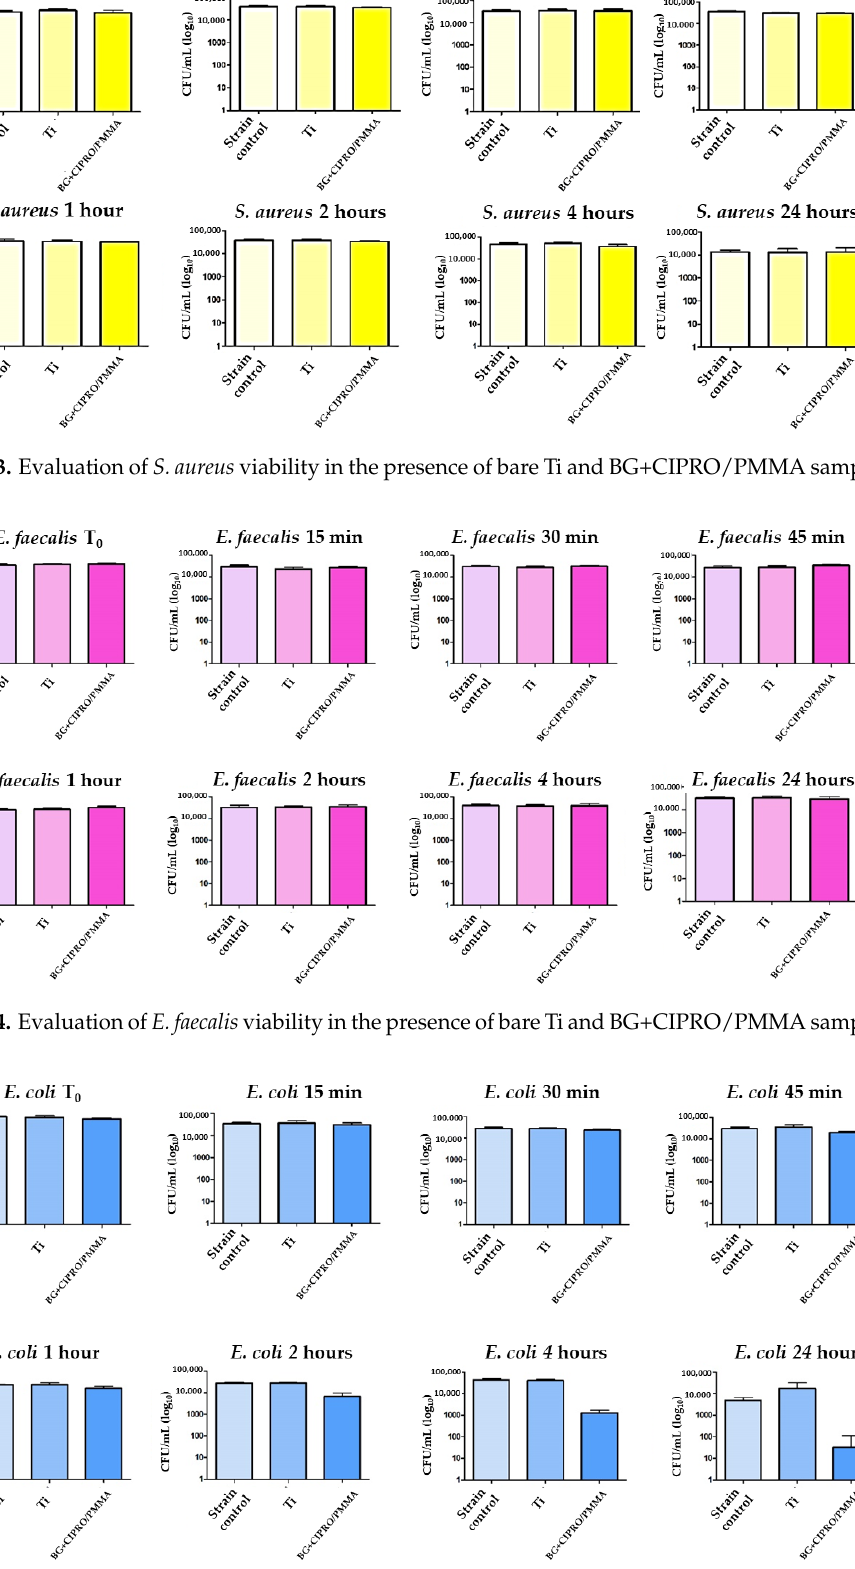
Figure 16. Evaluation of P. aeruginosa viability in the presence of bare Ti and BG+CIPRO/PMMA samples . Our results demonstrate that the antibiotic is released from MAPLE layers and is effective against Gram-negative bacteria starting with 45 min after the initial contact, while for Gram-positive strains we did not obtain an inhibition. Although ciprofloxacin is a second-generation quinolone with an extended spectrum including Gram-negative bacteria and some Gram-positive strains, the lack of an inhibitory effect against S. aureus and E. faecalis could be explained by the different structure of the cellular wall (e.g., the thick peptidoglycan of the Gram-positive strains delaying the intracellular accumulation of active concentrations). In the Gram-negative strains, the influx of fluoroquinolones is favored by porins expressed in their outer membrane, such as OmpF and OmpC in the case of E. coli [61,62]. 4. Conclusions The potential of BG+CIPRO/PMMA to bond to bone tissue is demonstrated by the presence of the carbonated hydroxyapatite layer. The MAPLE-processed coating proved to be a good candidate for the design of efficient implant surfaces BG+CIPRO/PMMA coatings successfully inhibited Gram-negative bacterial growth with no harmful effects on MC3T3-E1 osteoblasts.